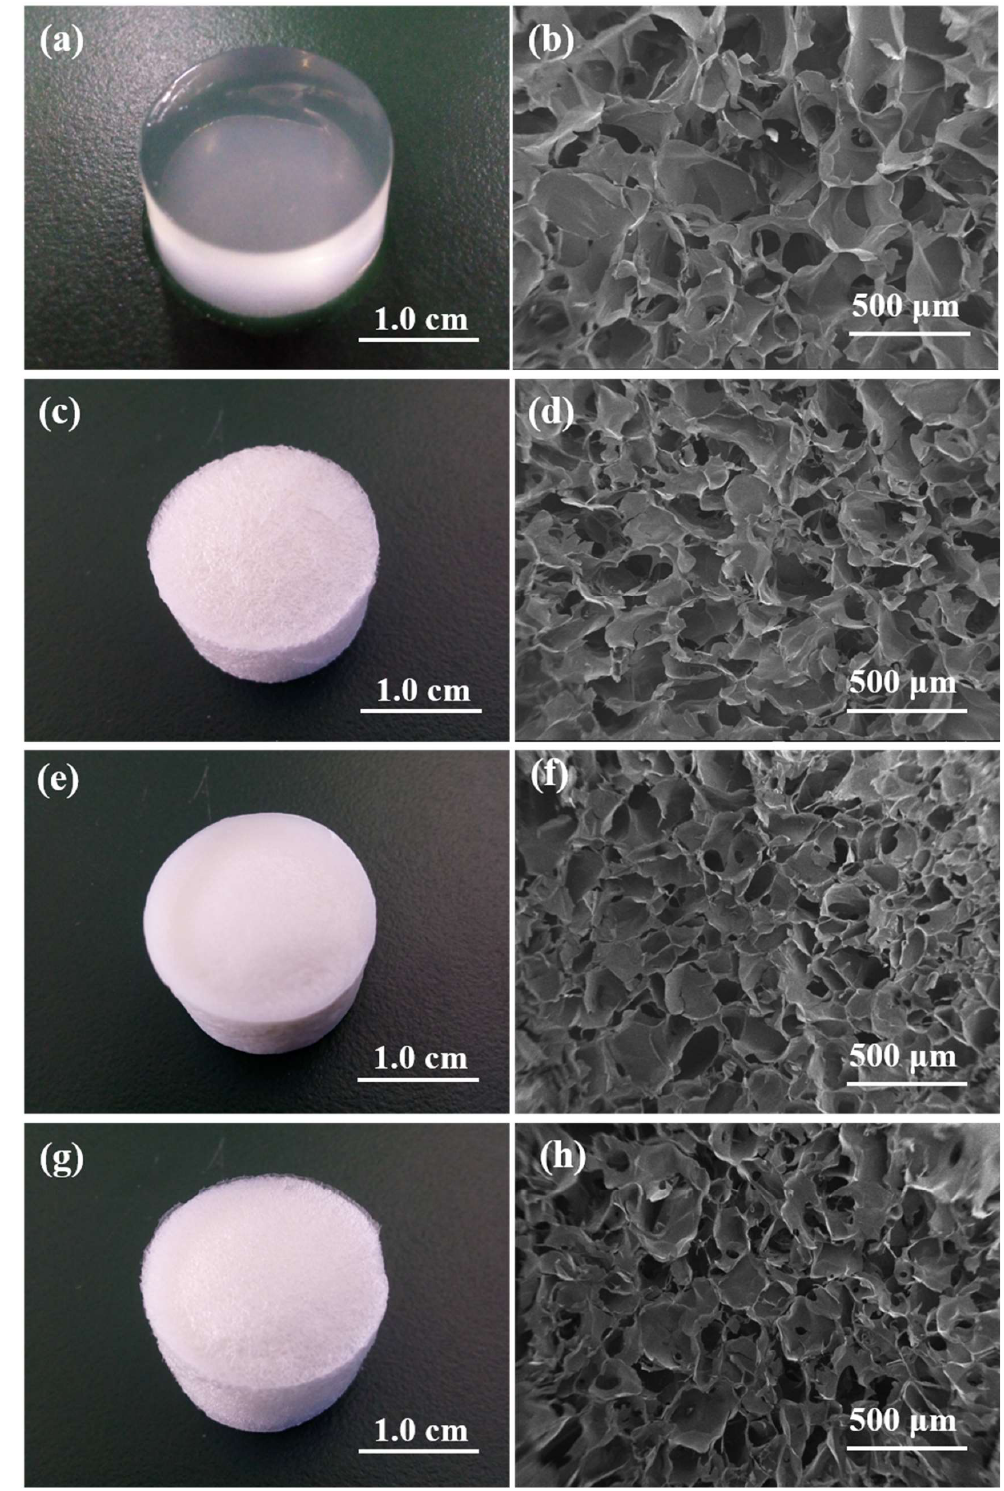
Figure 3. Photographs of ( a ) undried ALG Gel, ( c ) dried Alg-GT, ( e ) dried Alg-CS-GT and ( g ) dried ALG/GT-CS; SEM images of the cross-section of ( b ) ALG Gel, ( d ) Alg-GT, ( f ) Alg-CS-GT and ( h ) ALG/GT-CS.